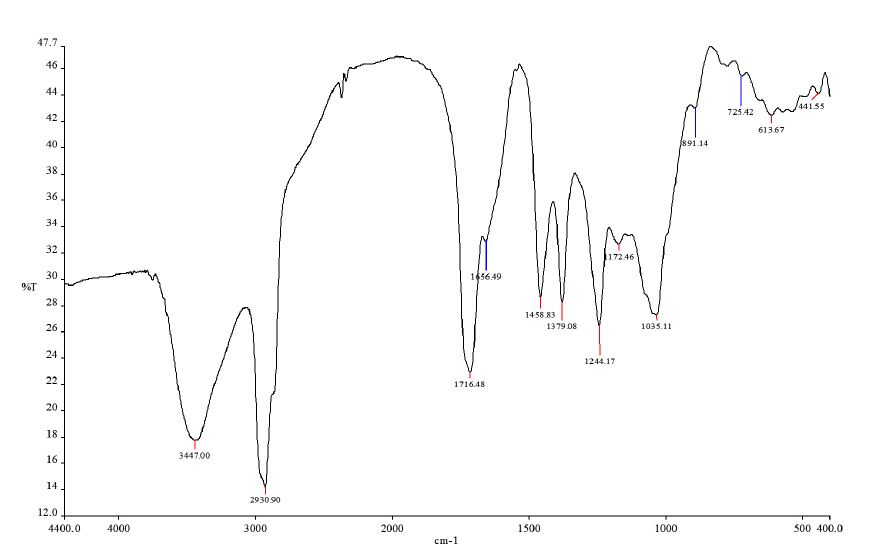
FTIR, Fourier-transform infrared. Fig. 3. FTIR spectrum of the aqueous extract of Boswellia